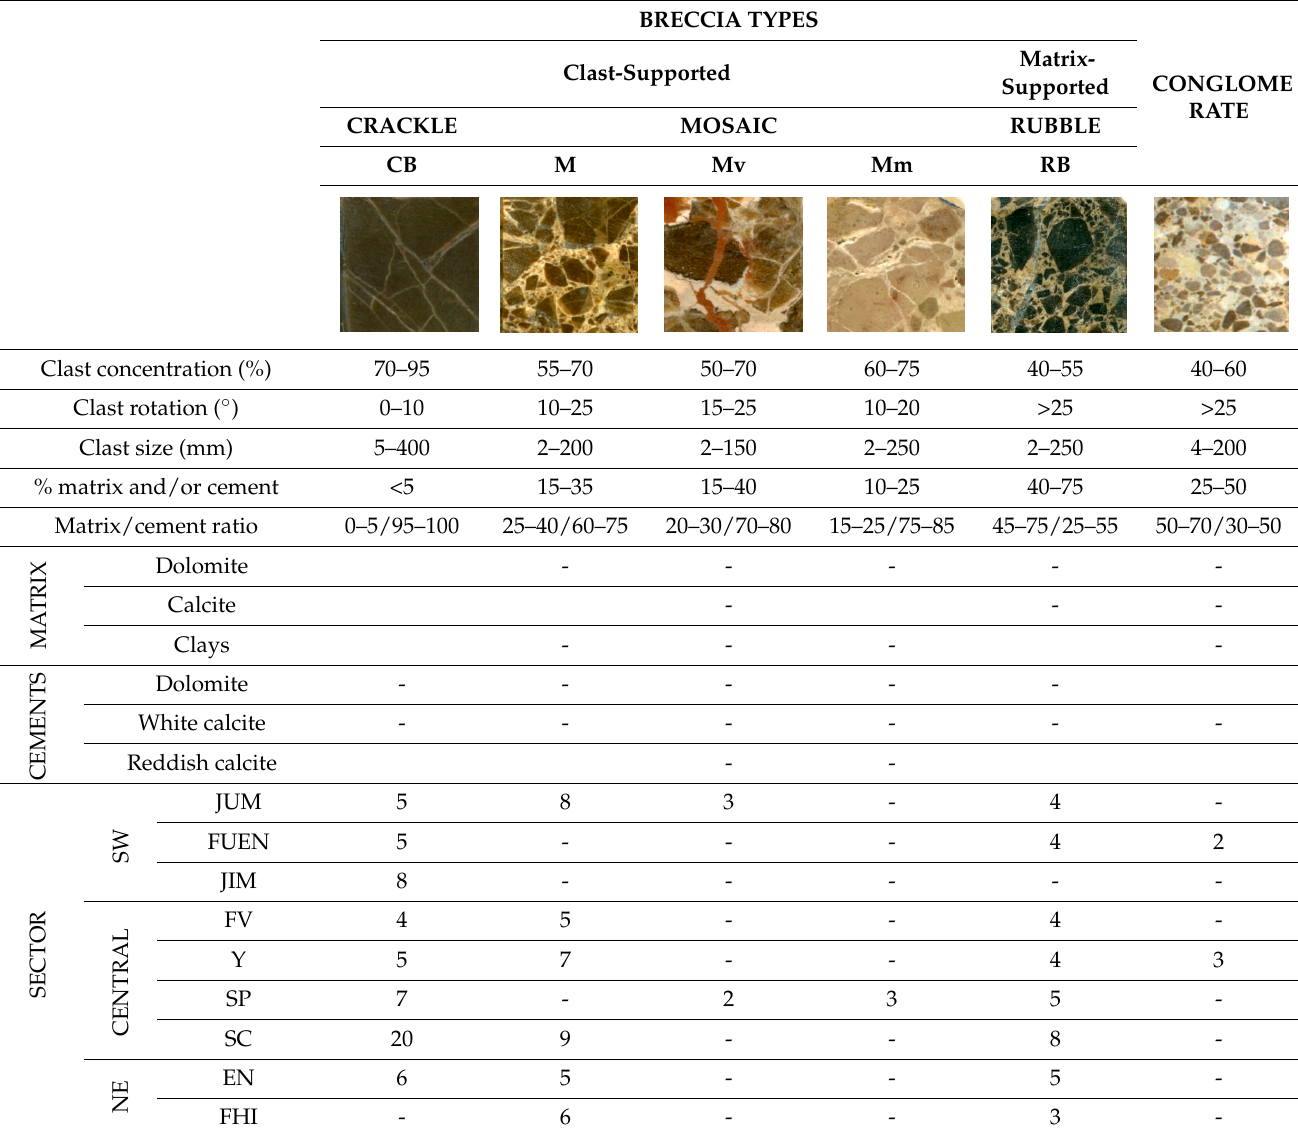
Table 1. Types and distribution of breccia facies in the study area. The number of collected samples for each breccia category in the studied sections is included.